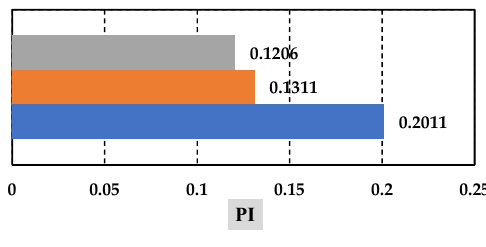
Figure 19. The change diagrams of each indicator for the ultimate strength model presented by Chen and Andrawes [26] and the proposed models.